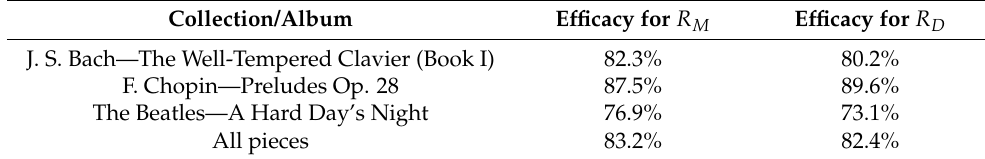
Table 4. Overall * efficacies of the key detection obtained for different weighted pitch-class represen- tations of analyzed fragments of music using a strictly correlational approach based on Temperley’s profiles (T), where R M —the multiplicities of occurrences of individual pitch-classes; R D —the aggre- gate durations of individual pitch-classes.